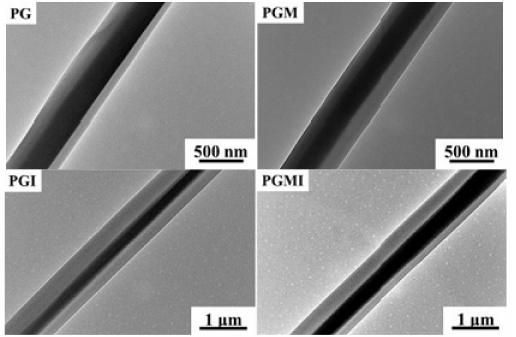
Figure 4. TEM images show the core-sheath structure of coaxial electrospun fibers with different components when electrospun for 30 min. Reprinted with permission from ref. [50]. Copyright 2019